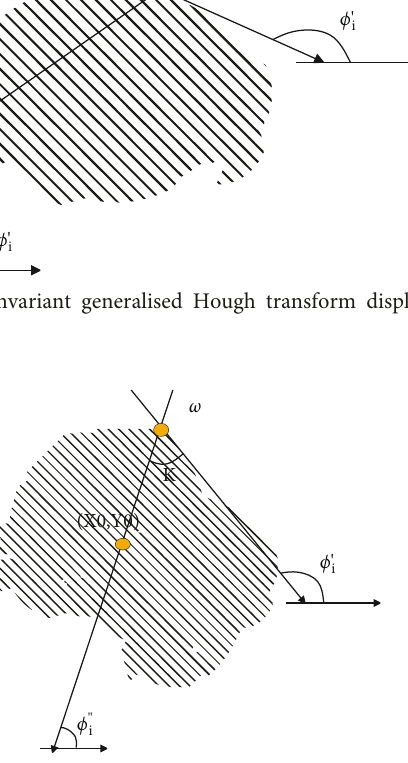
Figure 3: Invariant generalised Hough transform angle definition. Figure